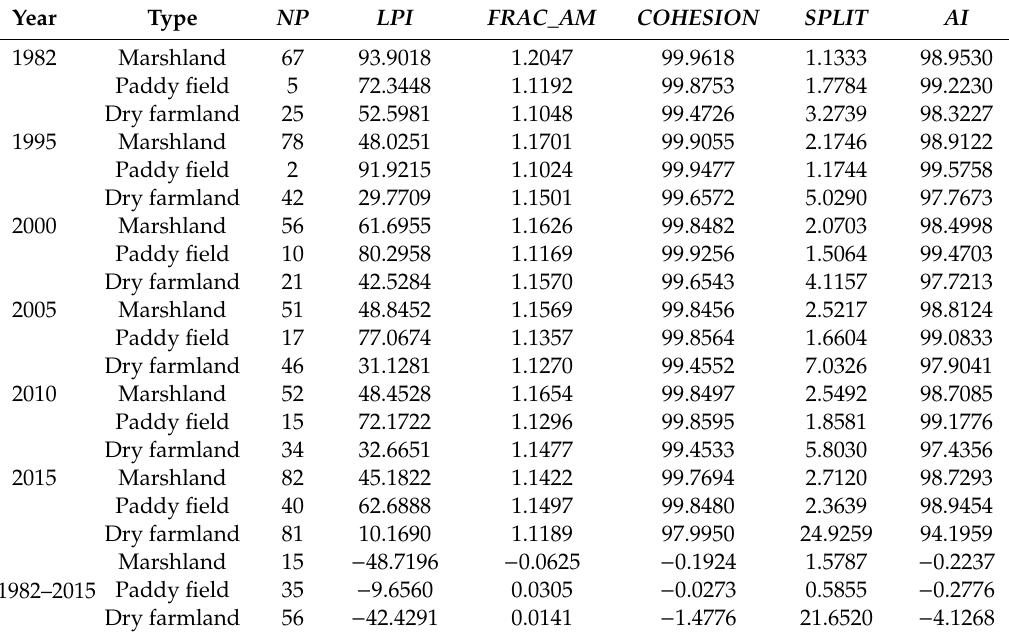
Table 4. Class level indices for landscape types in the Xingkai Lake